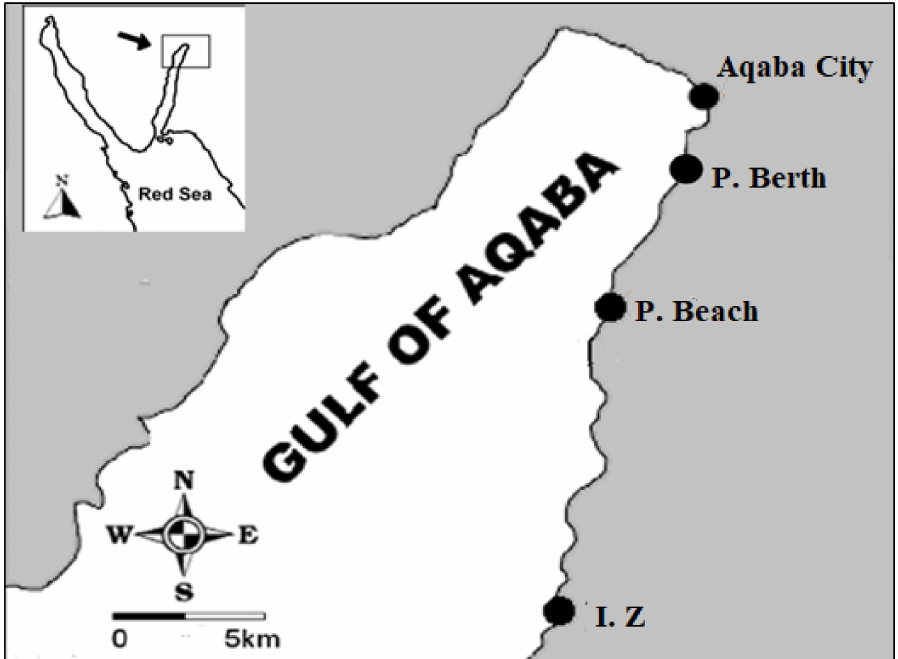
Figure 1. Sample sites in the Gulf of Aqaba (Jordan) (I.Z: Industrial Zone, P. Beach: Public Beach, and P. Berth: Phosphate